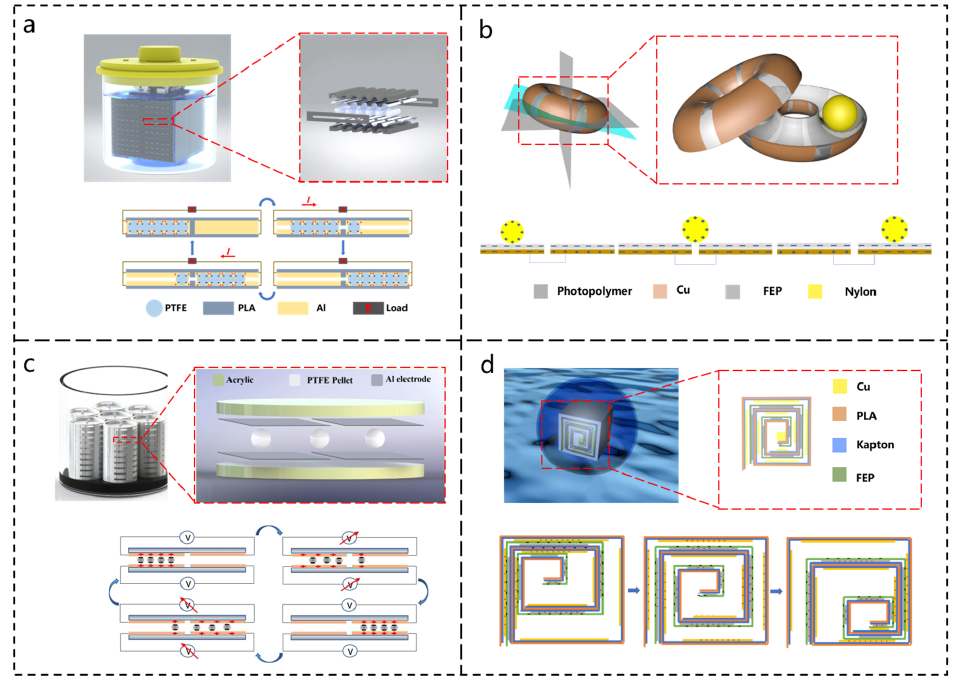
Figure 5. Triboelectric nanogenerator (TENG)-based PTO: ( a ) stackable fixed track TENG [101], reproduced with permission from MPDI; ( b ) torus track TENG [93], reproduced with permission from Elsevier; ( c ) stackable flexible track TENG [64], reproduced with permission from Elsevier; ( d ) whirling-folded TENG [100], reproduced with permission from the author. Table 2. Typical triboelectric nanogenerator (TENG)-based